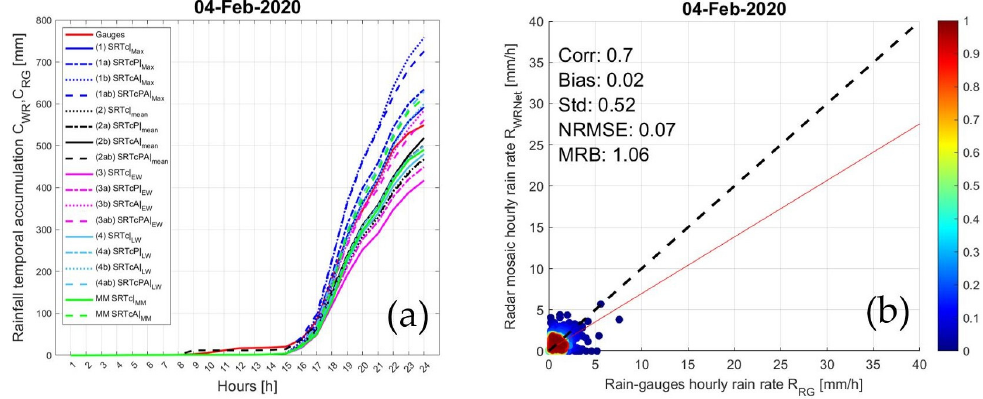
Figure 11. As in Figure 10, but for the event occurring on 4 February 2020.